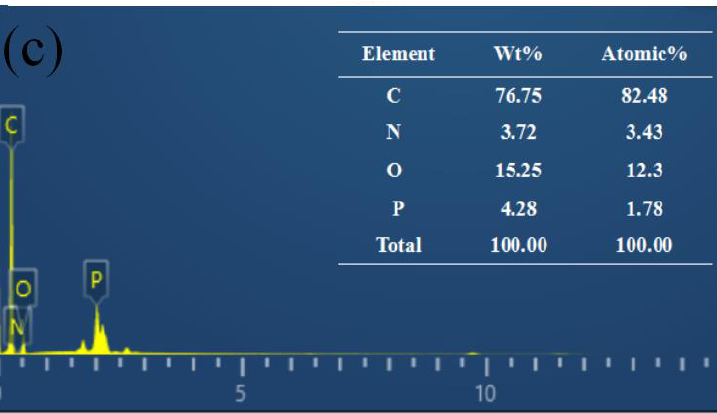
Figure 4. ( a ) 1 H−NMR spectra, ( b ) 13 C−NMR spectra and ( c ) EDS spectra of the D−fu . Figure 4. ( a ) 1 H − NMR spectra, ( b ) 13 C − NMR spectra and ( c ) EDS spectra of the